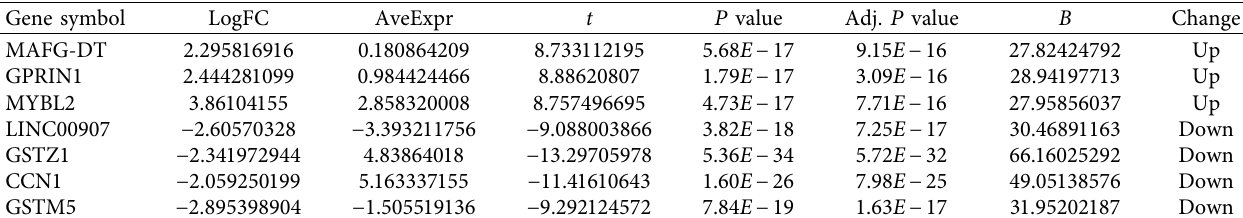
Table 2: 7 important DEGs related to